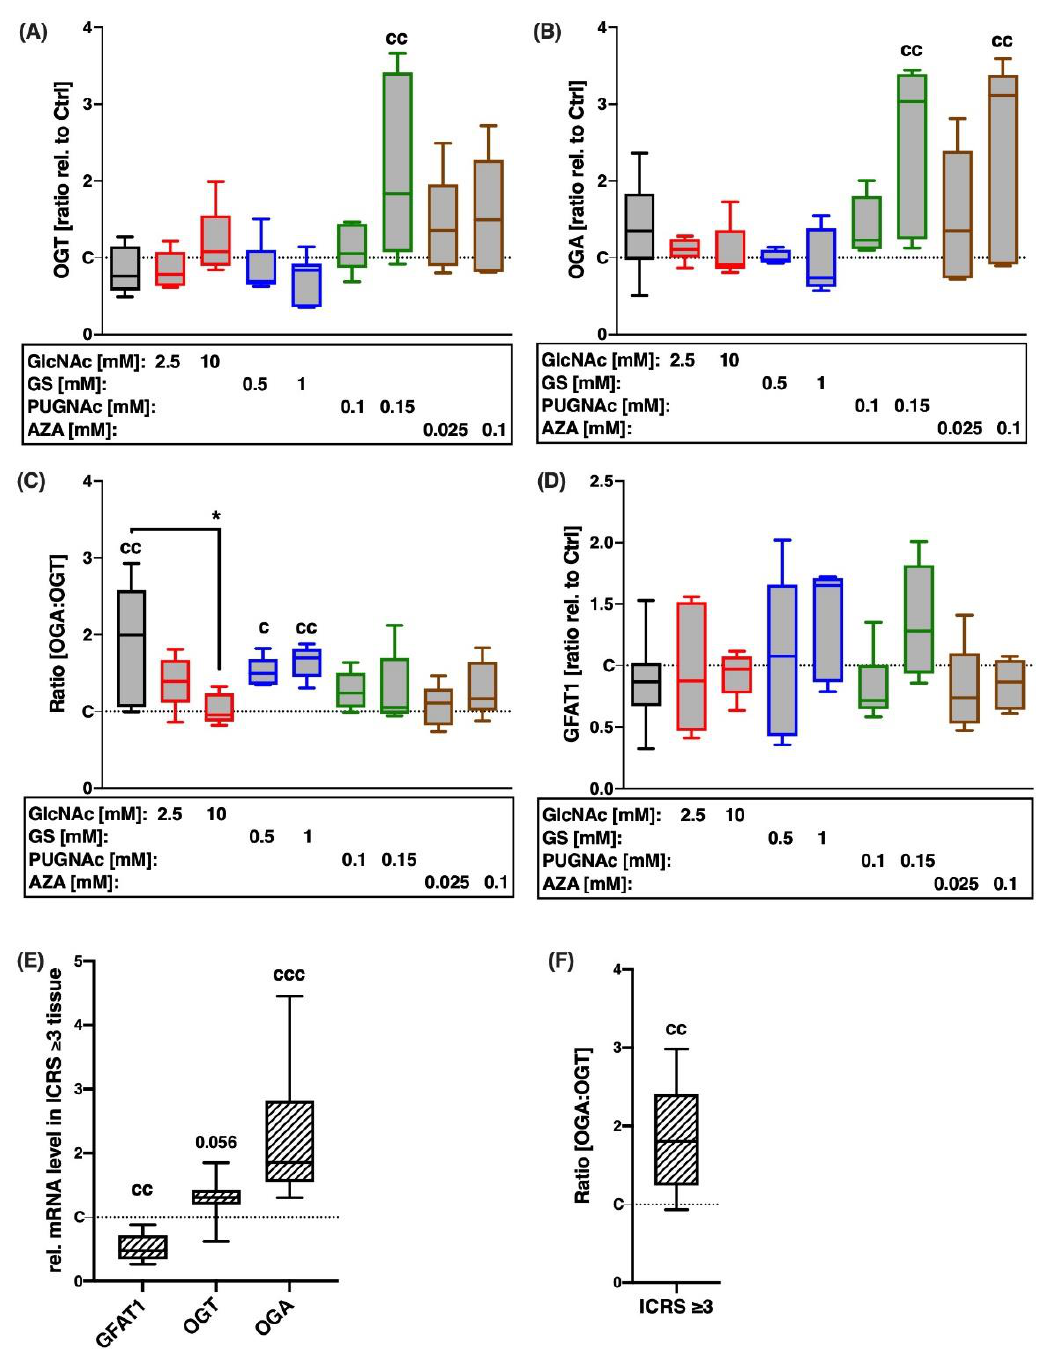
Figure 2. Gene expression levels of HBP-related enzymes 7 days after trauma and in highly degenerated tissue. Gene expression of HBP-related enzymes was evaluated in ( A , B , D ), impacted and subsequently treated cartilage explants, as well as ( E ) highly degenerated cartilage tissue (ICRS grade ≥ 3). Moreover, the ratio of OGA to OGT was calculated for ( C ) impacted and subsequent treated cartilage explants, as well as ( F ) OA cartilage. Statistical analysis: ( A , B , D ) one-way ANOVA, ( C ) the Kruskal–Wallis test, ( E ) multiple t-tests, ( F ) unpaired two-tailed t-test. Significant differences between groups were depicted as: [versus T] * = p < 0.05; [versus C] c = p < 0.05, cc = p < 0.01; all data sets n ≥ 5; ICRS grade ≥ 3 tissue n ≥ 6. Shaded boxes = traumatized cartilage explants (T), striped boxes = highly degenerated cartilage tissue (ICRS grade ≥ 3).